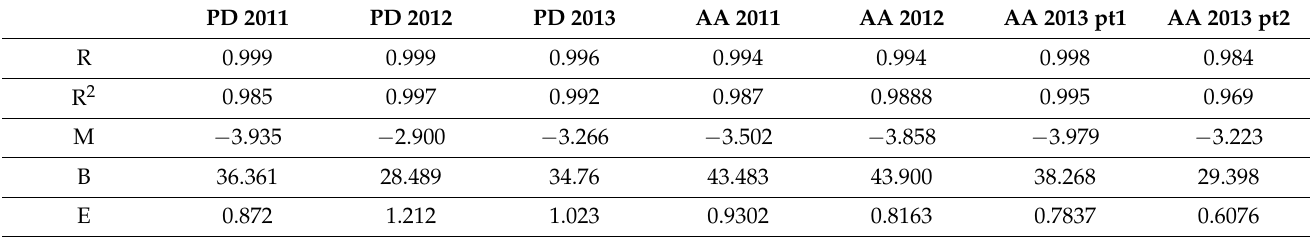
Table 3. Reaction efficiency of qRT-PCR assays in this study PD ( P. delicatissima ), AA ( Aureoccocus anophagefferens ) for assay run 2011, 2012 and 2013. E = efficiency, M = slope, B = offset or y-intercept, R, R 2 values indicate fit to the